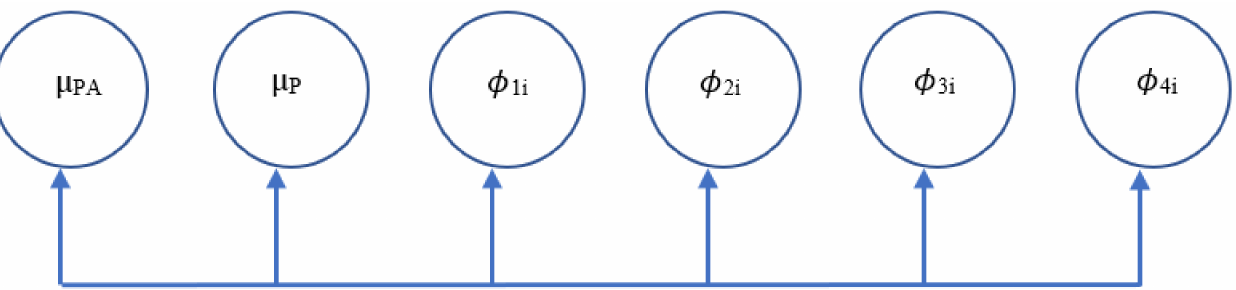
Figure 3. VAR(1) Model: Between-Person. Note . Figure 3 depicts the between-person components of the study model. PA represents physical activity, P represents pain, µ represents between-person means, and φ represents autoregressive